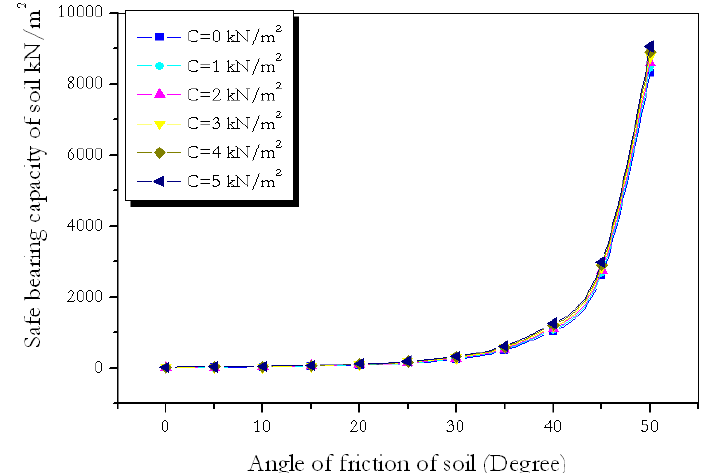
Figure 1: Safe bearing capacity Vs angle of friction of soil Sl.